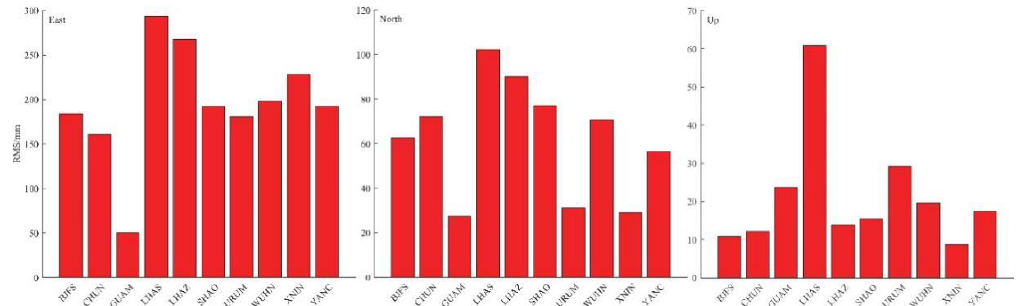
Figure 3. The root mean square (RMS) of ten sites in three coordination directions.